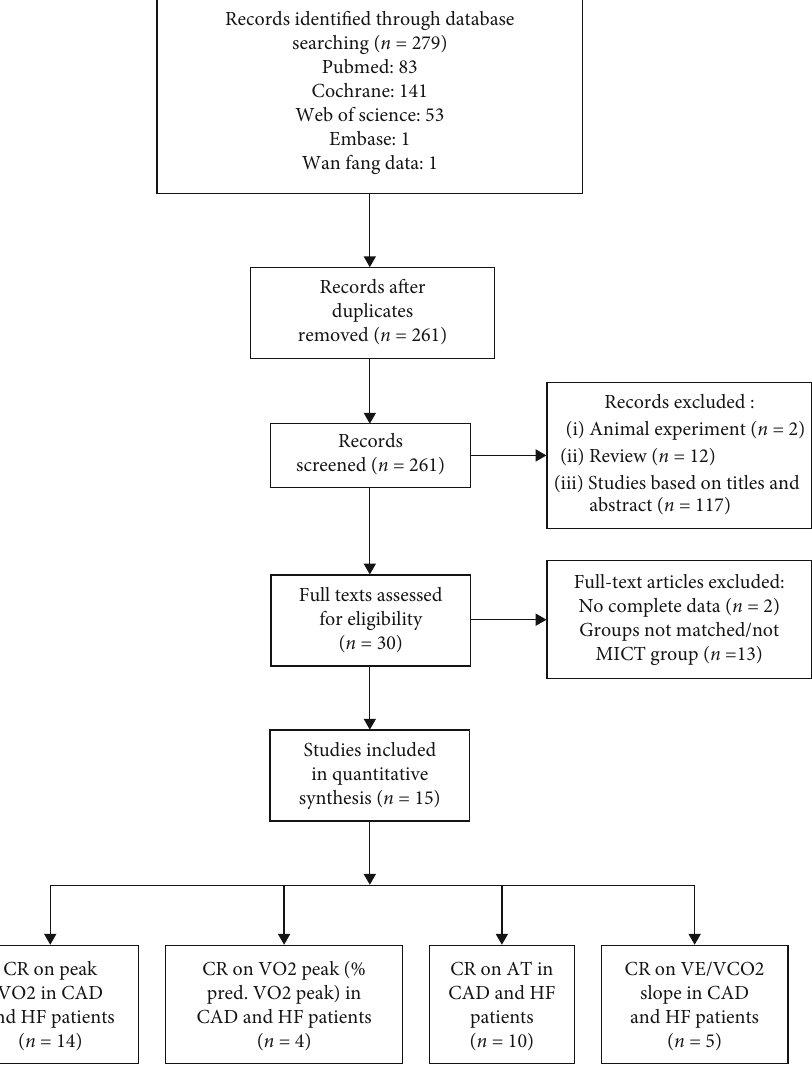
Figure 1: Systematic review process. CAD: coronary artery disease; HF: heart